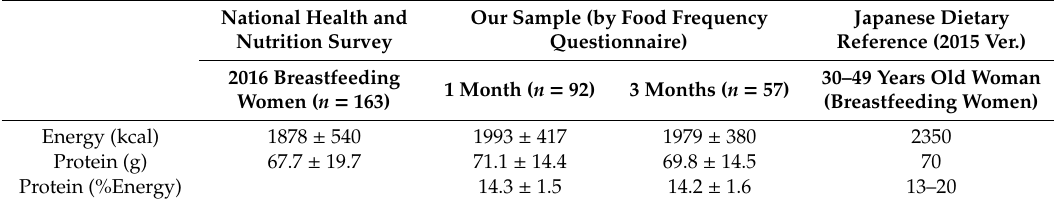
Table 2. Comparison with the National Health and Nutrition survey and Japanese dietary